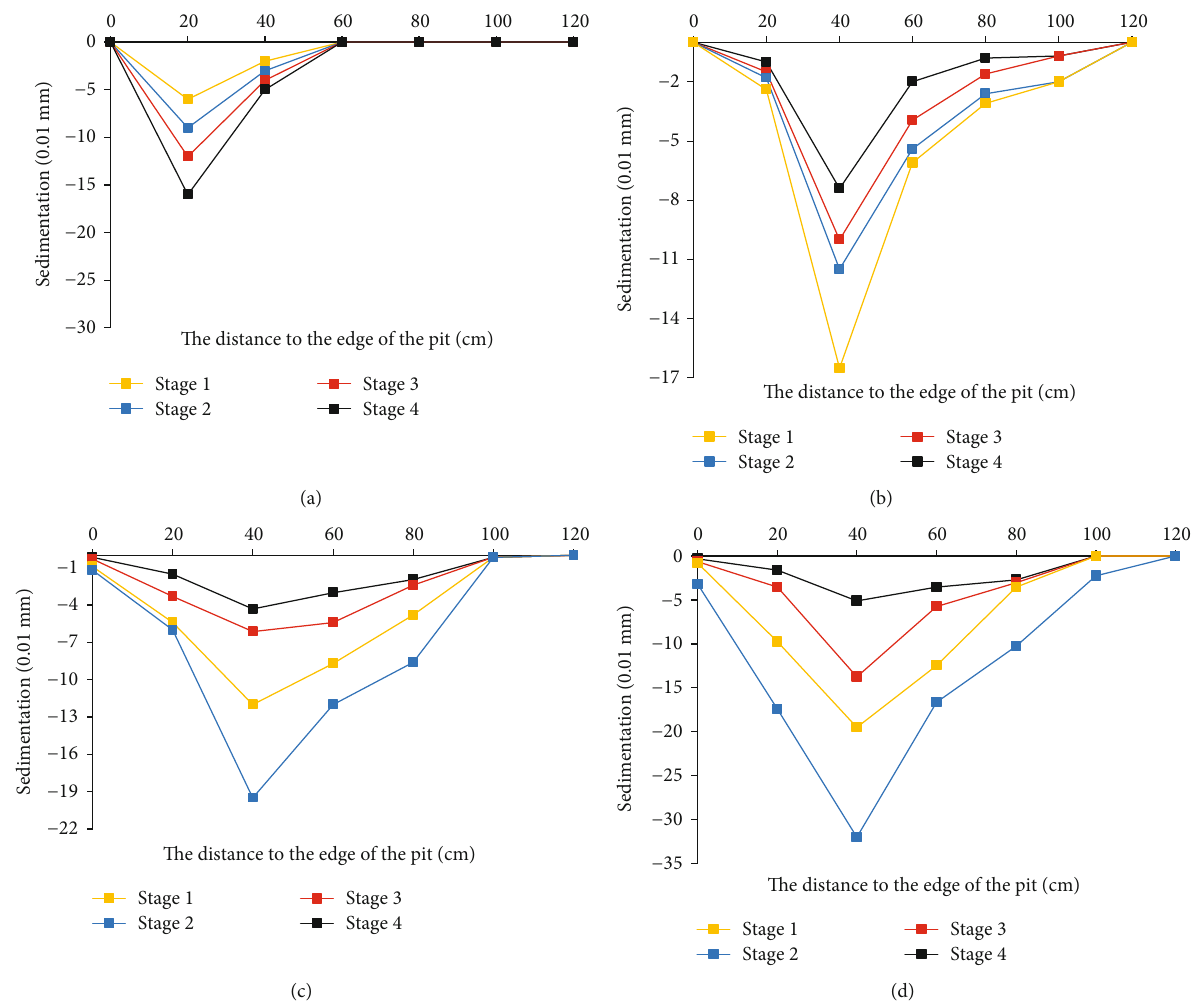
Figure 14: (a) Soil settlement of 0.41H; (b) soil settlement of 0.33H; (c) soil settlement of 0.27 H; (d) soil settlement of